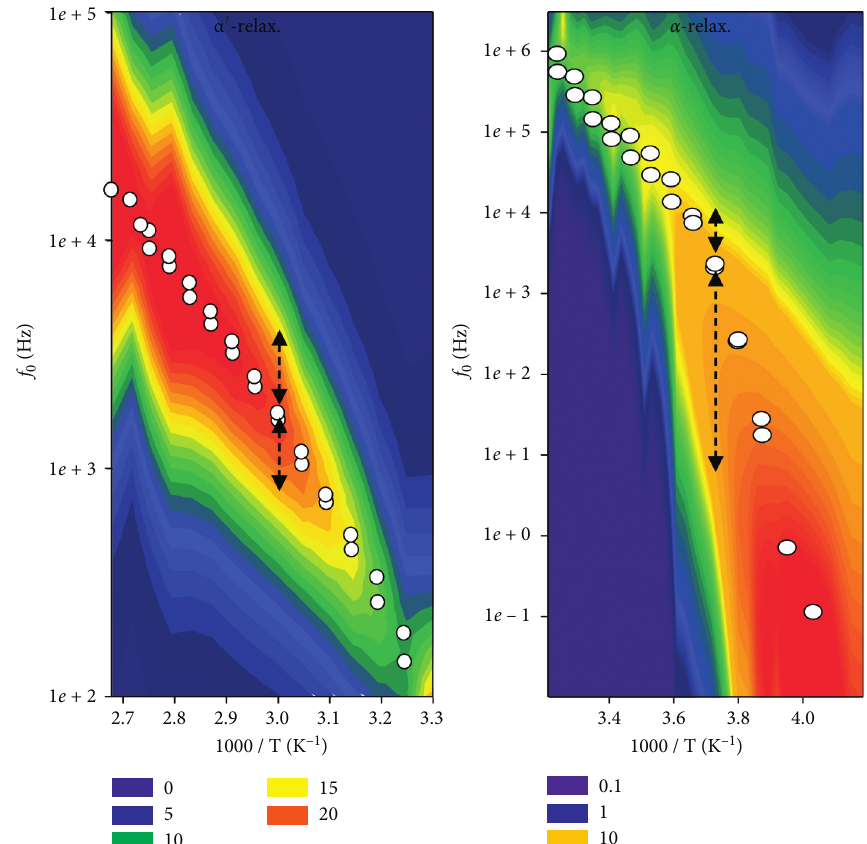
Figure 10: Relaxation rate and contour plot of the dielectric relaxation phenomena for NBR. The overlapped circle symbols just denote the repeated analysis.